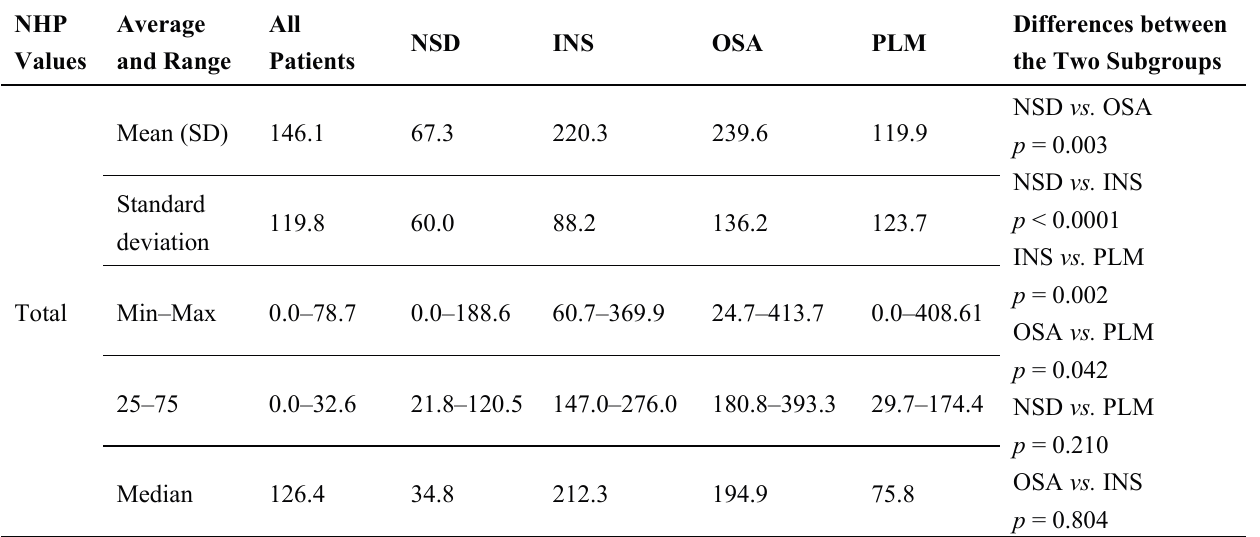
Figure 1. Nottingham Health Profile total values in the four subgroups. Table 2. NHP total score and NHP items in the different